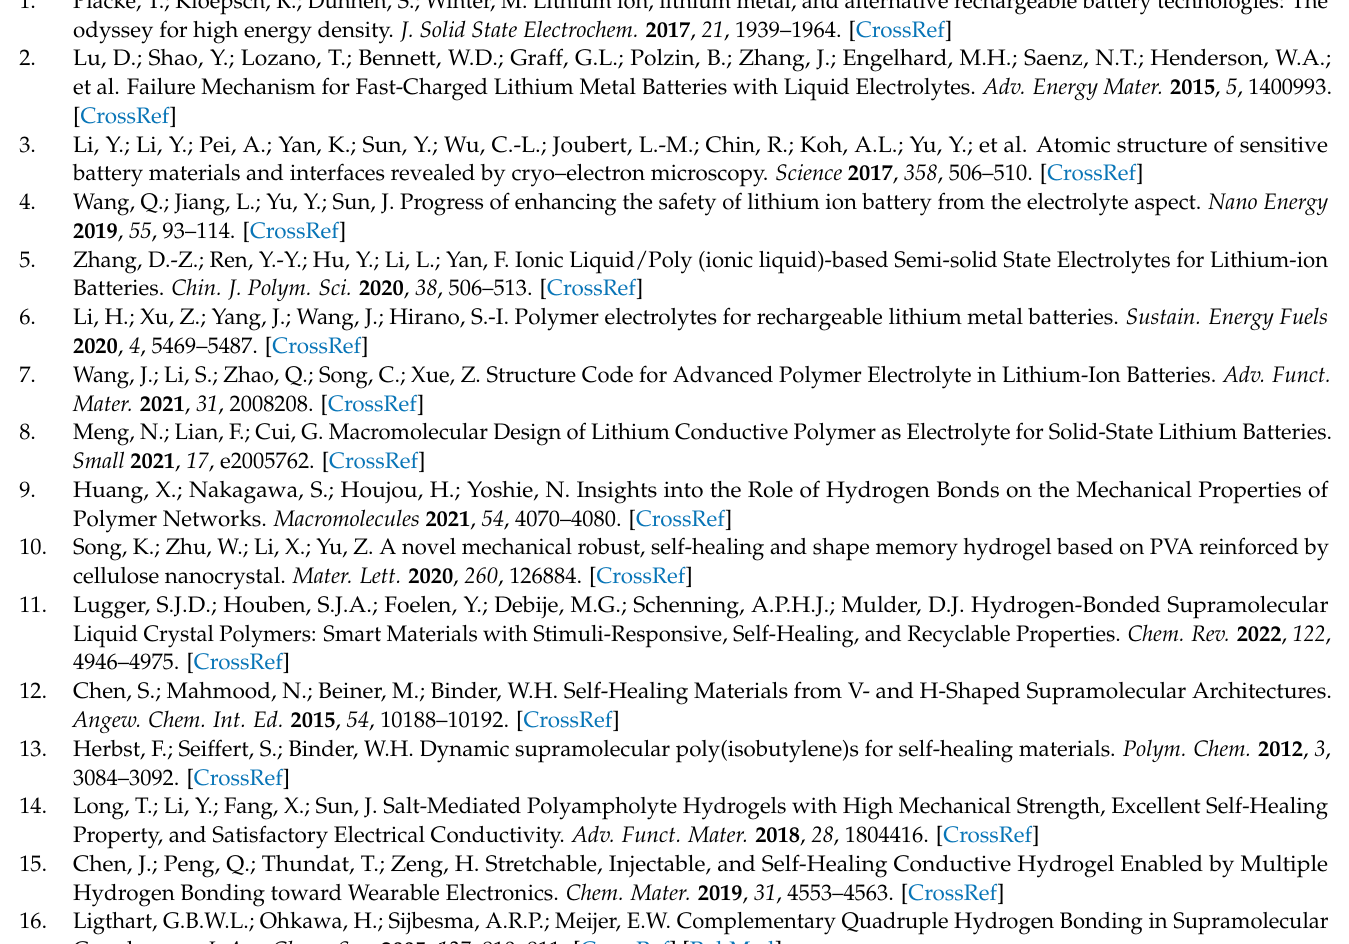
Figure S1–S4: GPC curves of all the polymers; Figure S5–S12 NMR spectra of all the compounds and polymers; Table S1: Synthesis data of the copolymers CPILU-9 and CPILU-10 for tensile test; Table S2: GPC data of precursor polymers pCPA and final POILC-z, planned for calibration; Table S3: Conductivity of POIL-x and CPILU-y from − 20 ◦ C to 80 ◦ C, measured by BDS; Table S4: Zero shear viscosity of POIL-x and CPILU-y from 50 ◦ C to 100 ◦